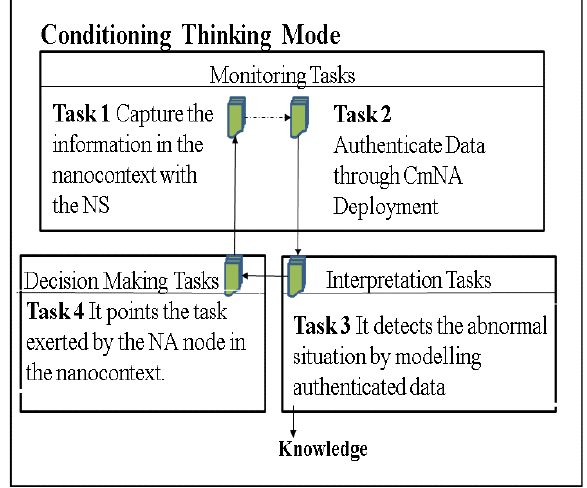
Figure 2. Tasks for the CTM-AC.